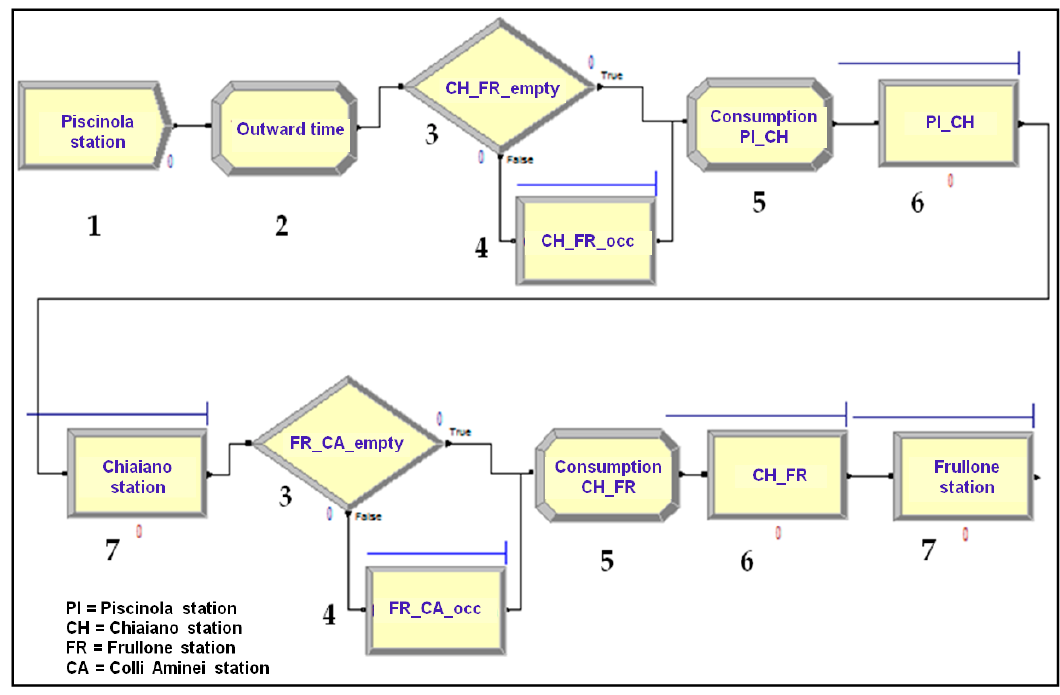
Figure 9. A portion of Line 1 implemented in Arena.